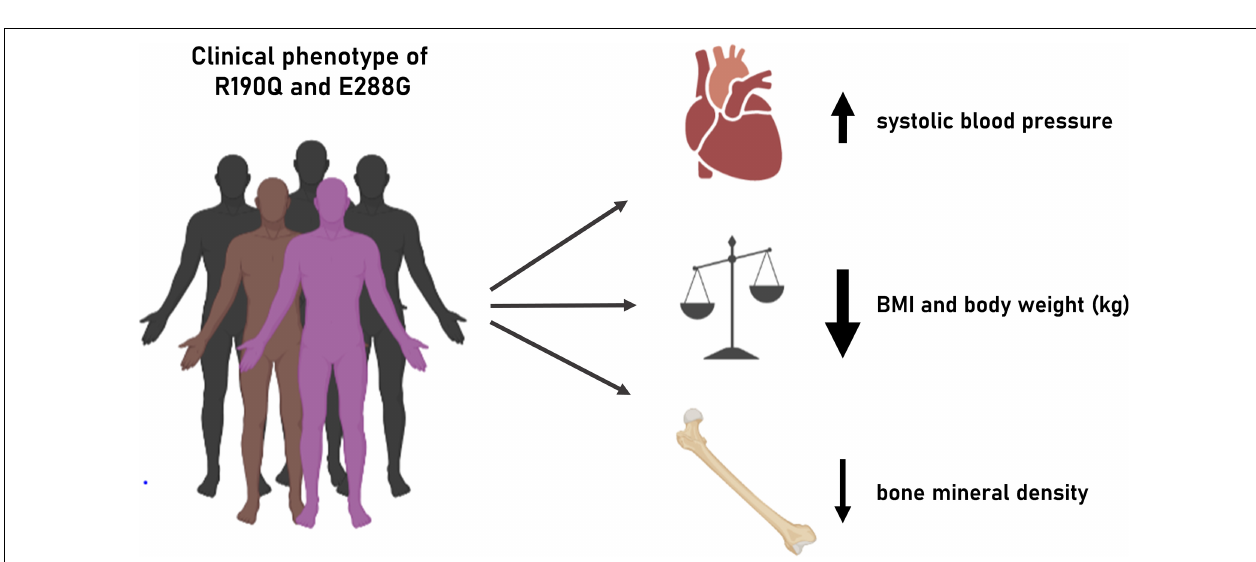
FIGURE 4 | Illustration of clinical phenotype of GIPR R190Q and E288G. Overview of the clinical phenotypes associated with the two GIPR variants presented in this